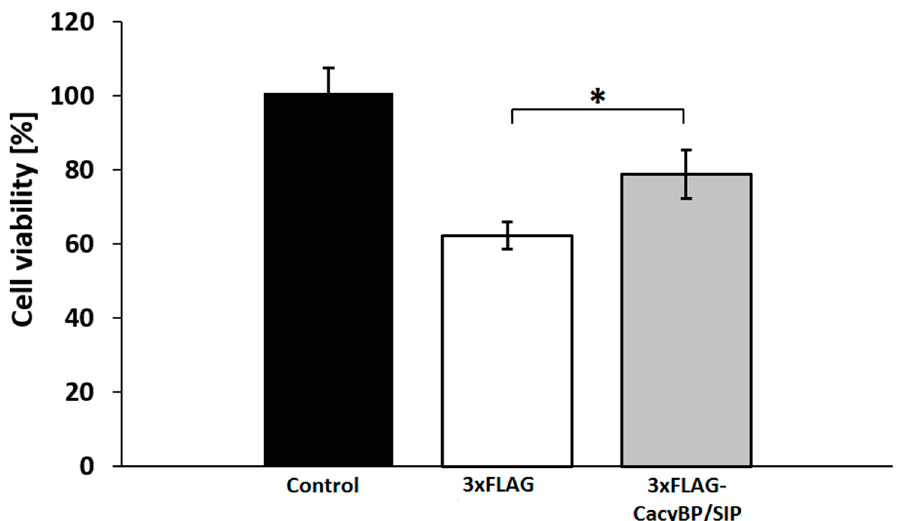
Figure 9. Viability of HEK293 cells overexpressing CacyBP/SIP after rotenone treatment. Cells treated with solvent (black bar), cells transfected with 3xFLAG (white bar) or with 3xFLAG-CacyBP/SIP (grey bar) treated with rotenone. Cell viability was quantified using an MTS assay. Data obtained from 3 independent experiments, calculated as means ± SEM, are presented as percentage values. * p ≤